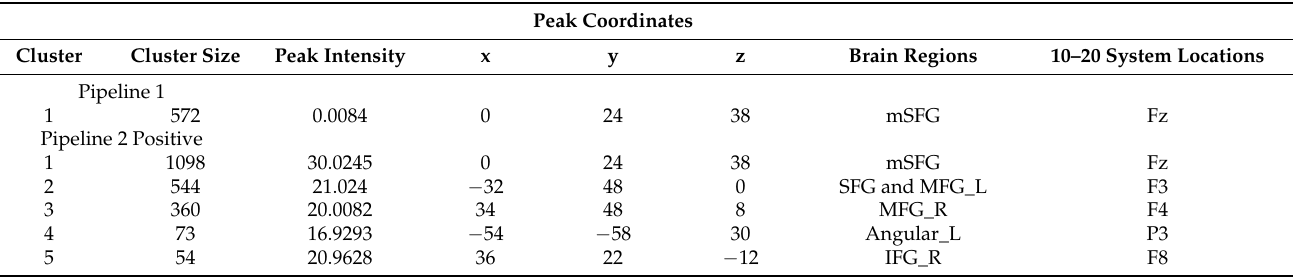
Table 3. Potential targets identified from three